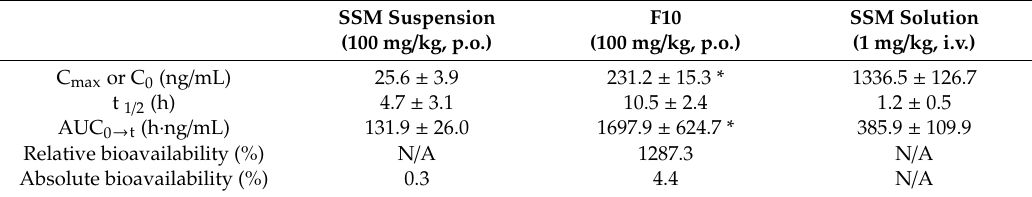
Figure 7. The plasma concentration–time profiles of SSM after drug administration in rats: ( ■ ) indicates F10 (100 mg/kg, p.o.); ( ▼ ) indicates SSM suspension (100 mg/kg, p.o.); ( ● ) indicates SSM solution (1 mg/kg, i.v.); data are expressed as the mean ± standard deviation of the mean ( n = 6 for each group). Table 2. Pharmacokinetic parameters of SSM in